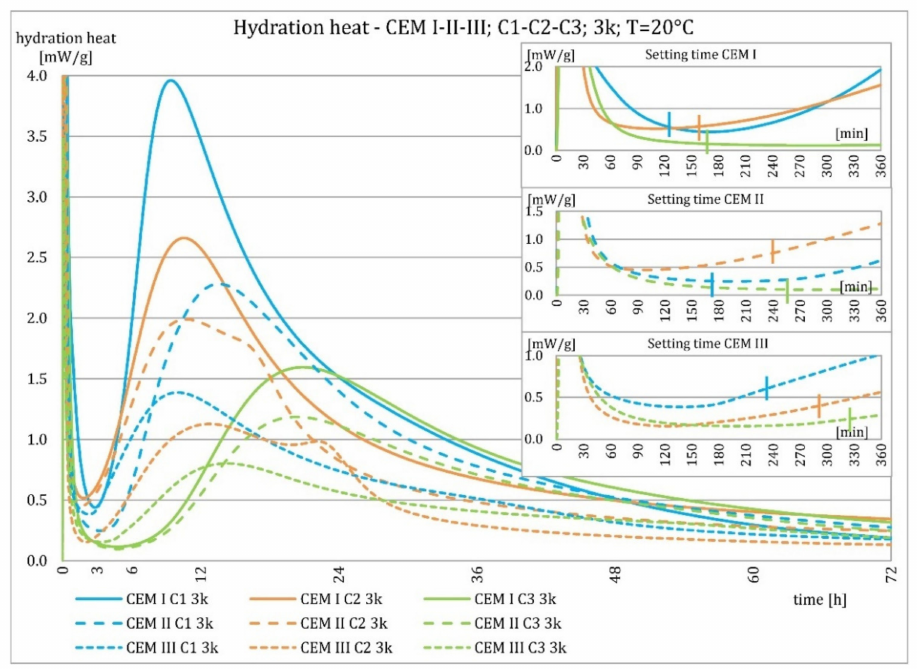
Figure 16. Hydration heat of C1-C2-C3 clinker based non-modified cements CEM I, CEM II/B-S, CEM III/A at 20 ◦ C.